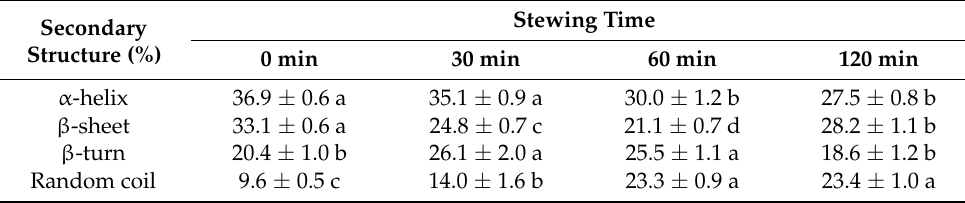
Figure 4. The effect of stewing time on the Raman spectra of collagen. ( A – D ) represents samples at 0, 30, 60 and 120 min, respectively. Table 1. The effect of stewing time (0, 30, 60 and 120 min) on the secondary structure of collagen.